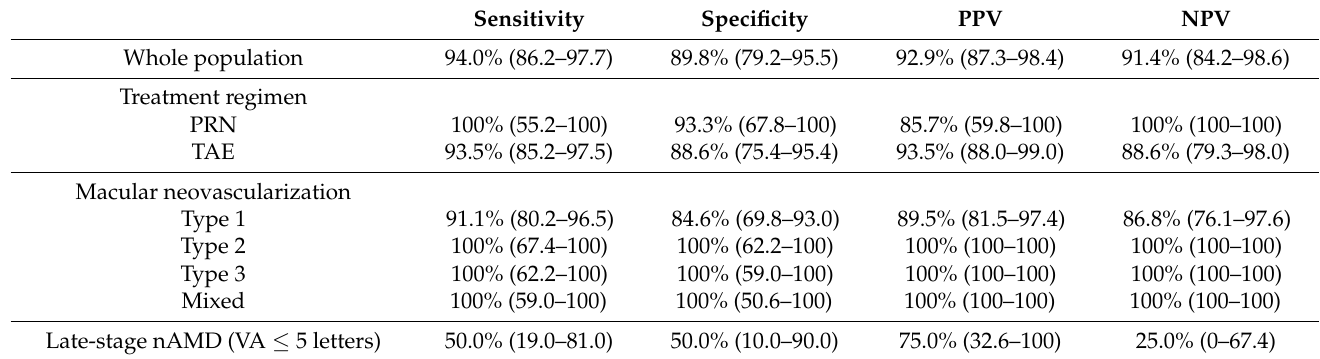
Table 3. Sensitivity and specificity of OCT-guided strategy for retreatment decisions in nAMD patients.